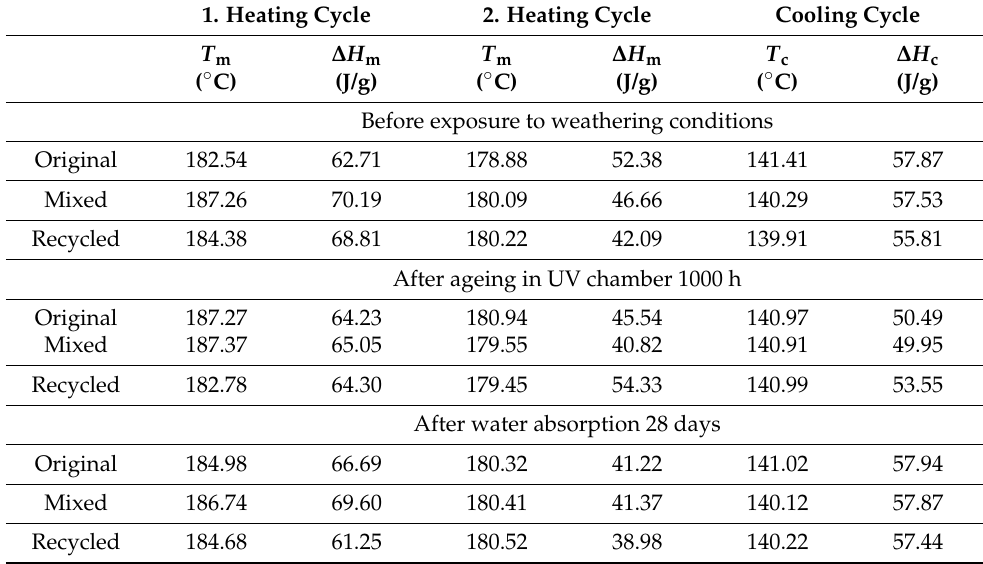
Table 1. Results of DSC